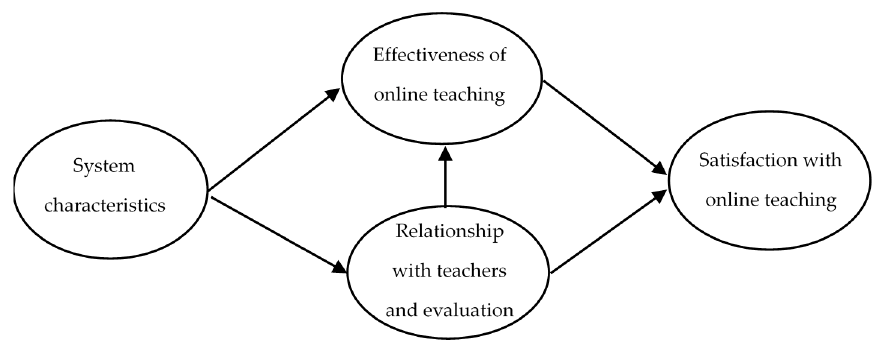
Figure 1. S tructural model specified for the derivation of the importance of attributes. Figure 1. Structural model specified for the derivation of the importance of